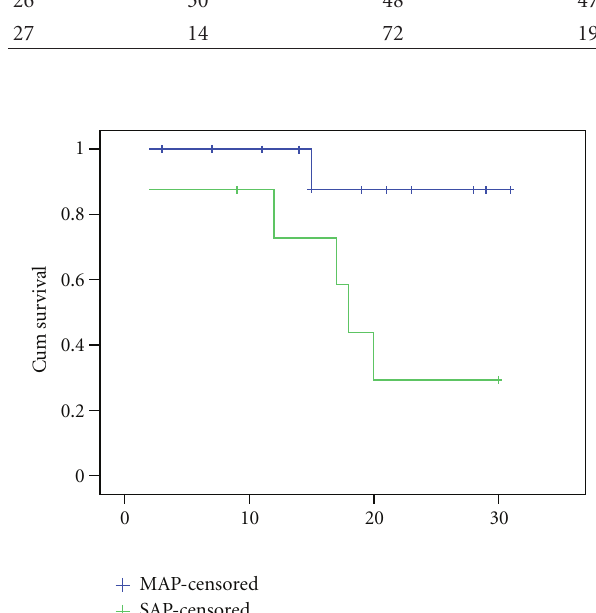
Figure 1: Kaplan-Meier survival curves for the time (days) from onset of SLE-related acute pancreatitis to